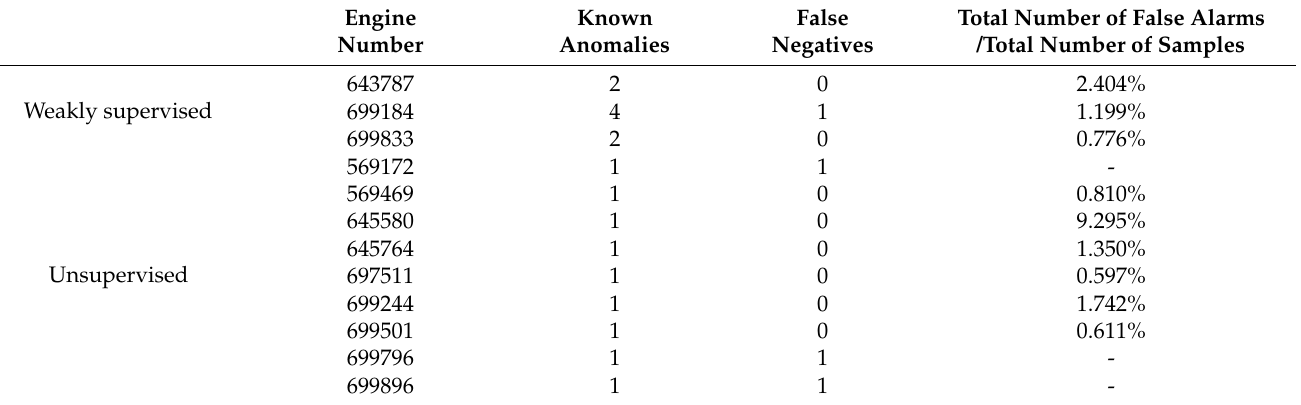
Table 7. Anomaly detection result for the WSFE +